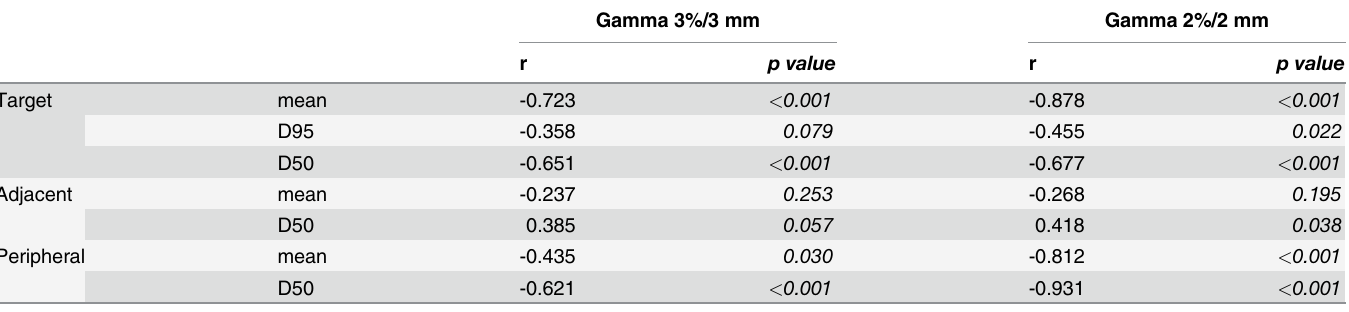
Table 7. Correlations between the magnitude of dose difference and the gamma passing rate of each region of interest (ROI), calculated with both gamma 3%/3 mm and 2%/2 mm criteria.